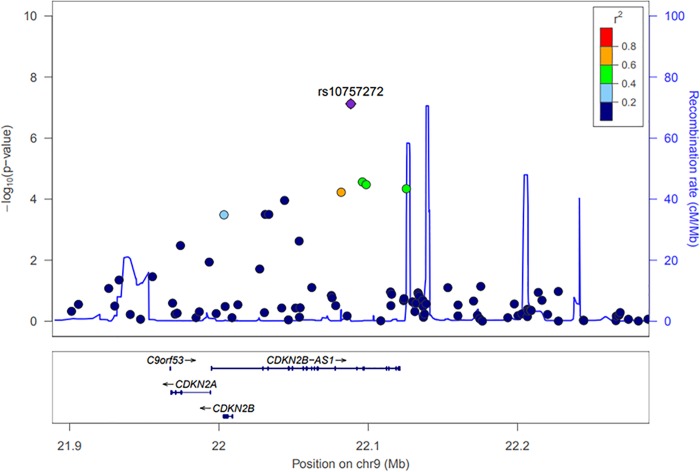
Regional association plot in chromosomes 9.The purple diamonds indicate the associated SNP according to joint analyses. Nearby SNPs are color-coded according to the level of linkage disequilibrium with the top SNP. The left y-axis shows the significance of the association on a -log10 p-value (logistic regression), and the right y-axis shows the recombination rate across the region. Estimated recombination rates from the 1000 Genomes Project Asian base data and hg19 database [19] are plotted with the blue line to reflect the local linkage disequilibrium structure.